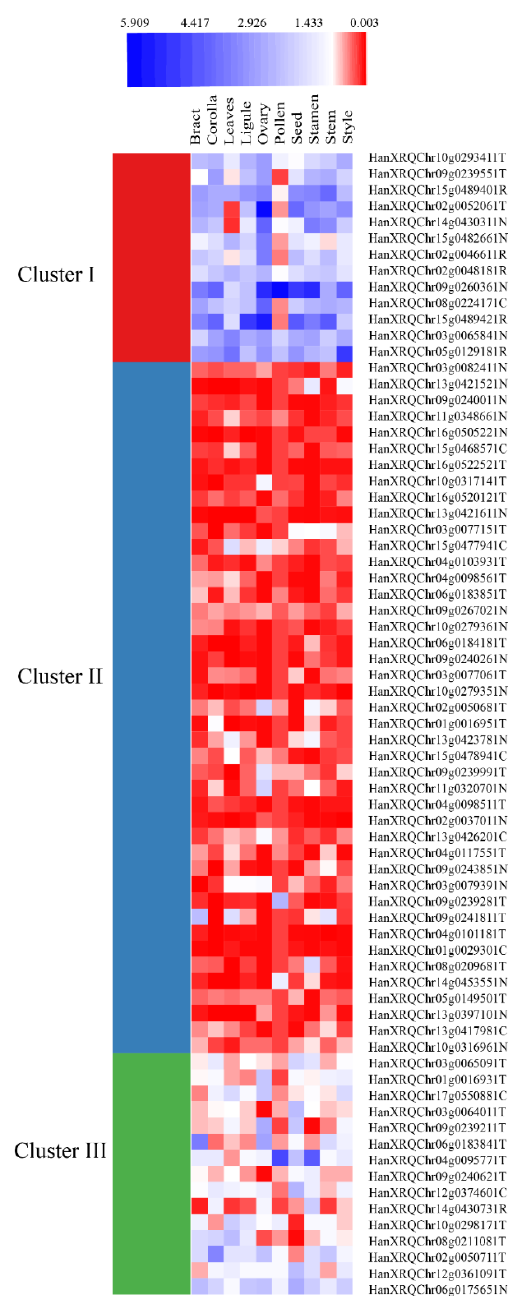
Figure 6. Expression profile of NBS genes from sunflower visualized as heatmap. The heatmap was generated using deseq normalized data for sunflower NBS genes expression in different tissues.